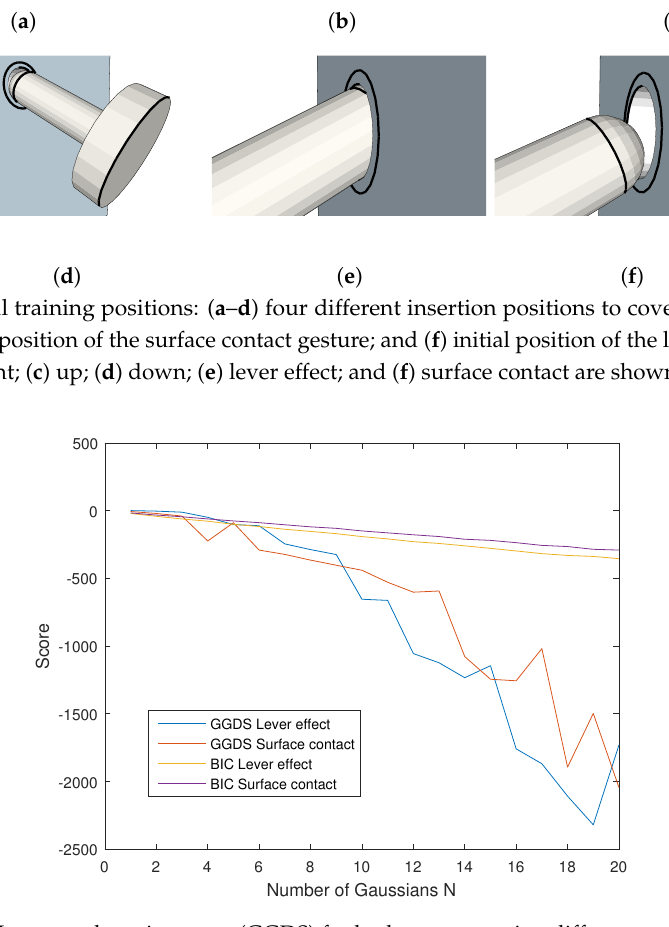
Figure 7. GMM gesture detection score (GGDS) for both gestures using different number of Gaussians. The figure shows the GGDS score decreased exponentially as the number of Gaussians was increased.